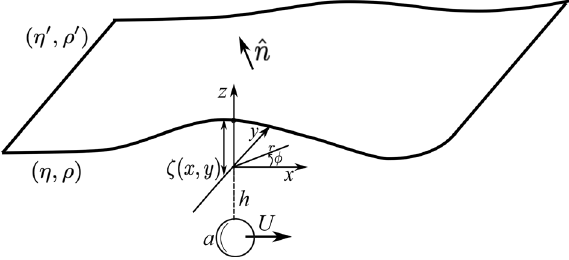
Figure 1. A soft interface separates two immiscible fluids and the shear exerted on this interface from a moving micro-particle, will deform it. The deformation pattern shown here, is pictorial and it does not necessarily shows a real pattern for a specific motion of a